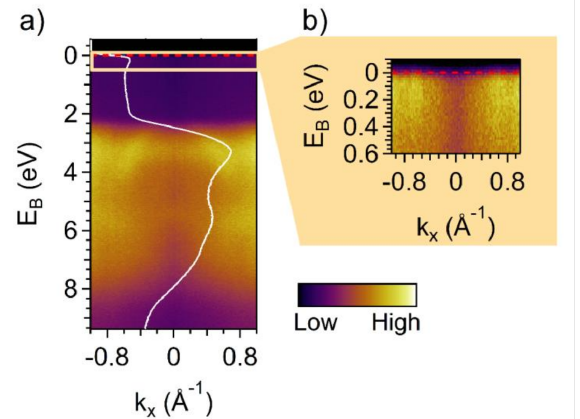
Figure 5. ARPES energy dispersion map of SrRuO 3 measured with 70 eV photon energy at room temperature. ( a ) Valence band dispersion and angle-integrated DOS showing spectral intensity at the Fermi level (white profile superimposed to ARPES spectrum). ( b ) Zoom to the area close to the Fermi level indicating the states responsible for the metallic nature of the